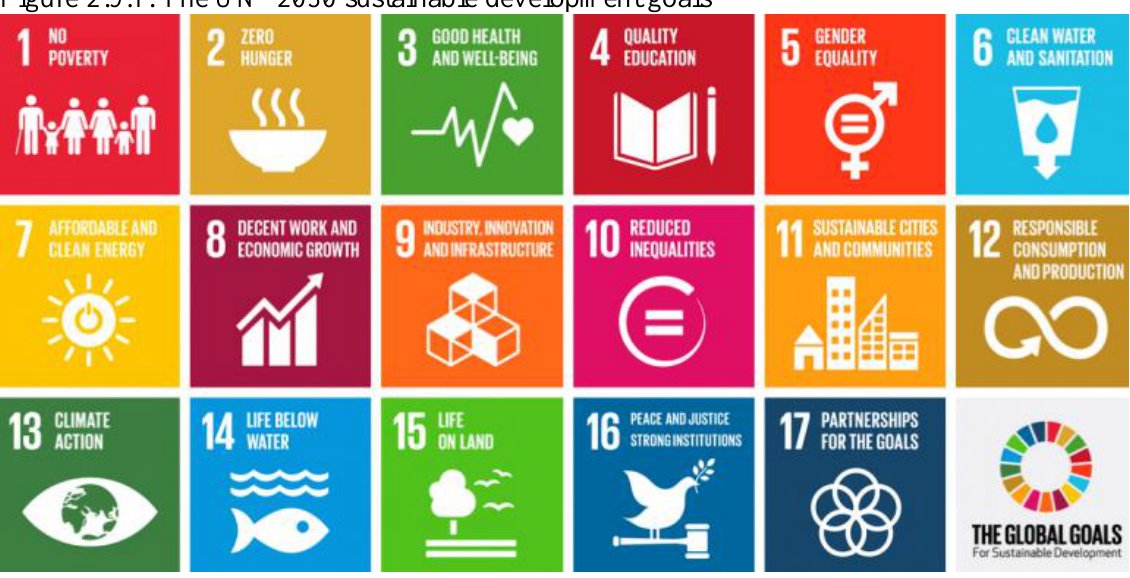
Figure 2.9.1: The UN -2030 sustainable development goals